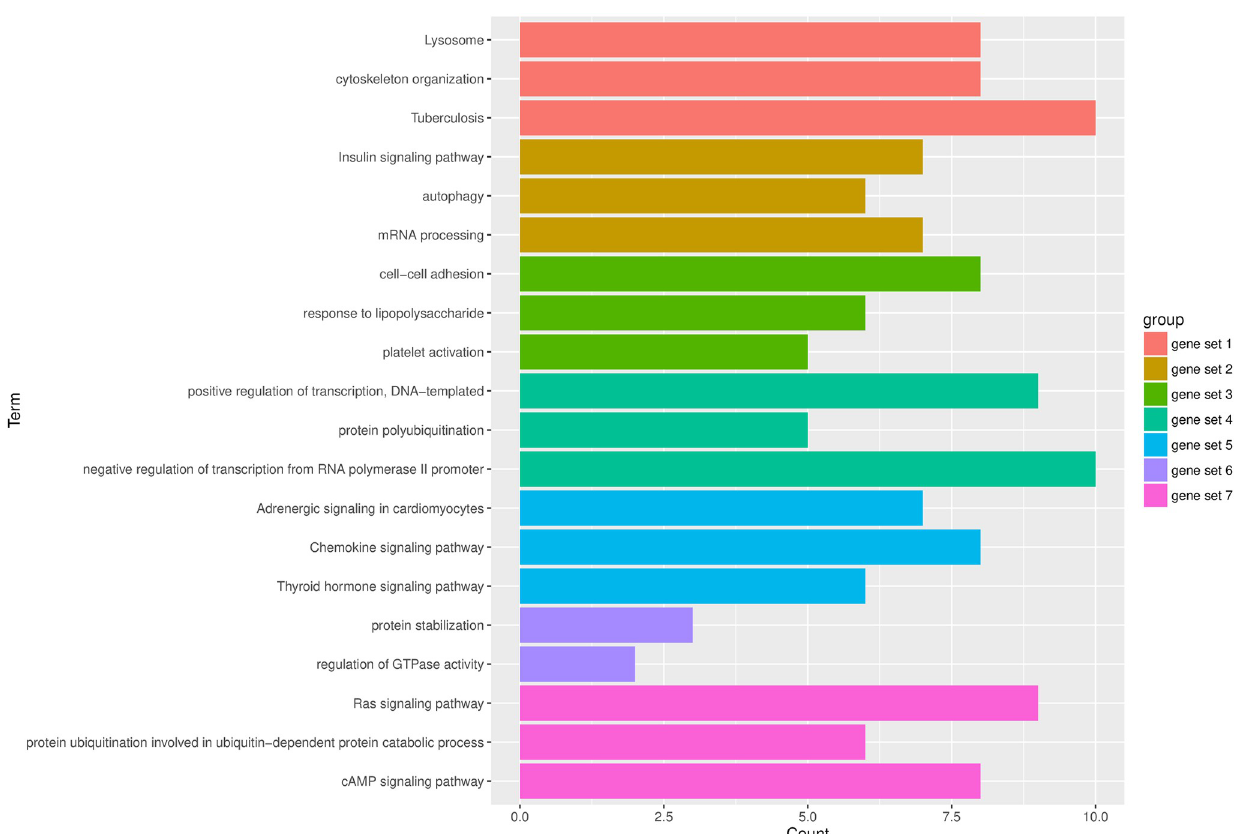
Fig 5. The most significant functions in seven gene sets. The x-axis represents the gene count and the y-axis represents the functions regulated by each gene